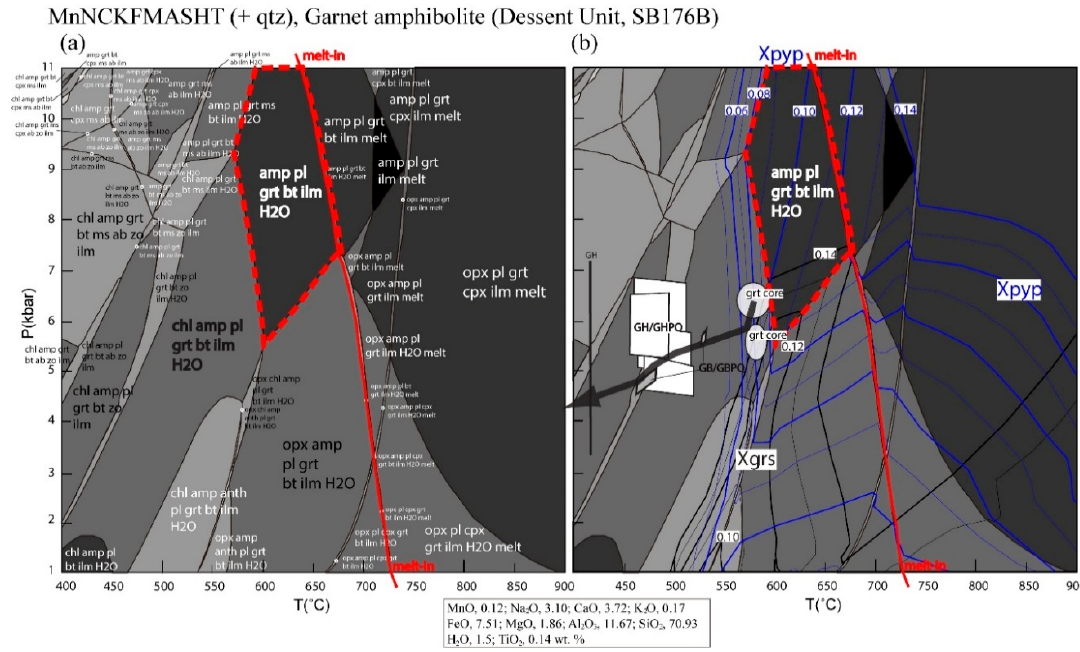
Figure 10. ( a ) P–T pseudosection for the amphibolite (SB176B) in the MnNCKFMASHT system. ( b ) P–T pseudosection with compositional isopleths of garnet porphyroblast for pyrope and grossular. The P–T path is identified by the garnet isopleths and GH / GHPQ and GB / GBPQ geothermobarometries. Mineral abbreviations are the same as those in Figure 7.